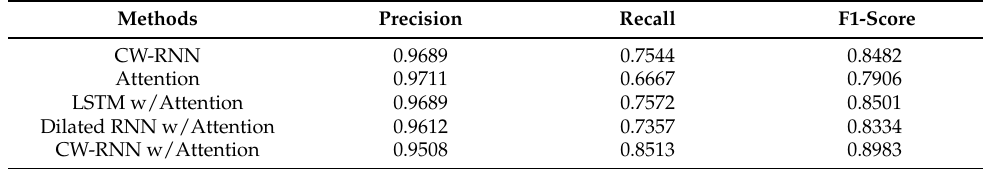
Table 3. Performance of different aggregators.